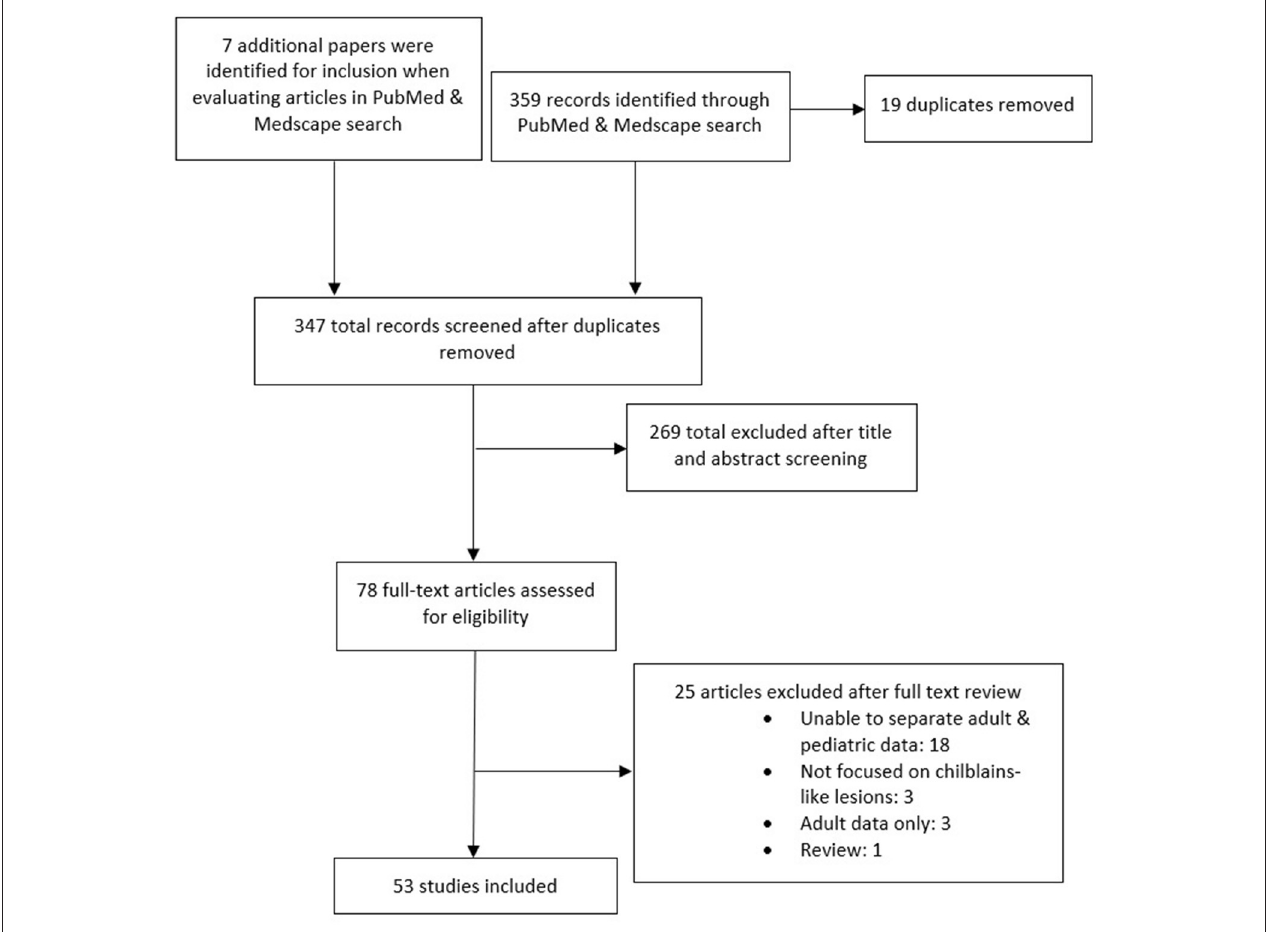
FIGURE 1 | Flowchart of the study selection